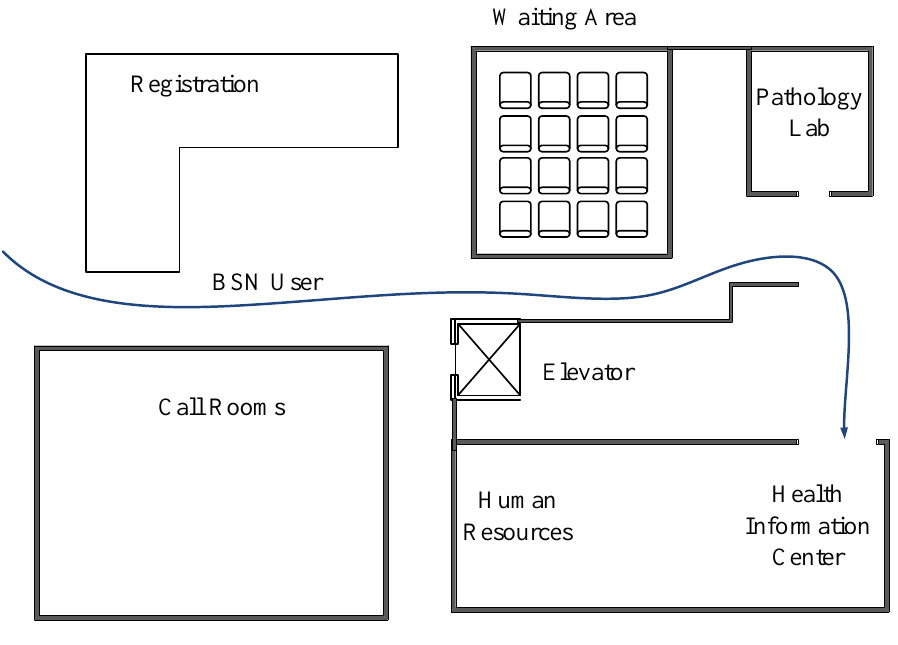
Figure 9. Floor map of Emergency Department in UK Good Samaritan Hospital.